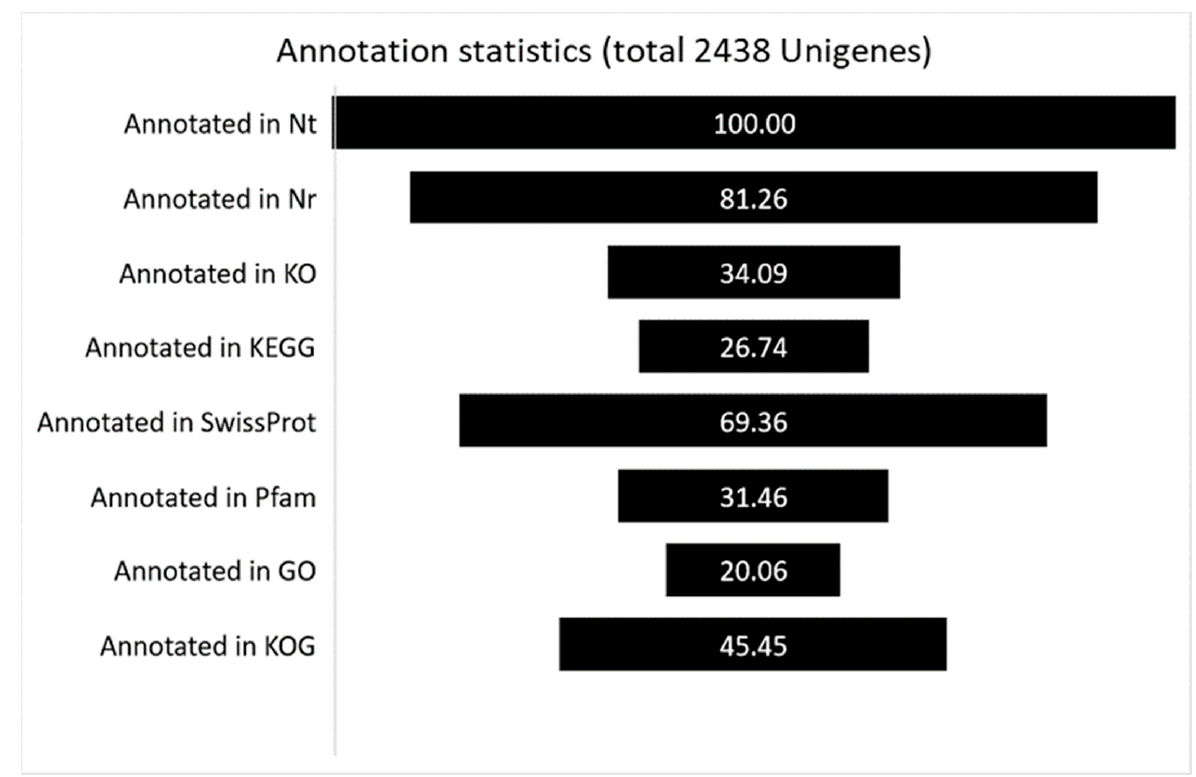
Figure 1. The percentage of successful annotated genes in several databases.